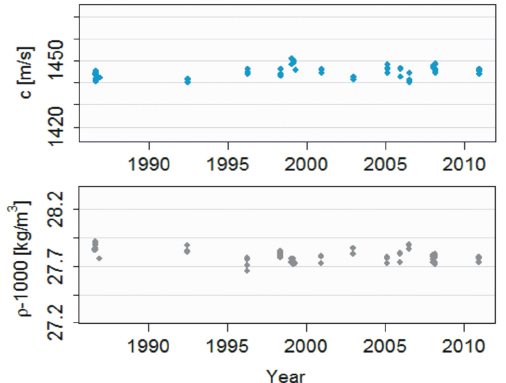
Figure 5. Vertical mean sound velocity (upper panel) and den- sity (lower panel), calculated from CTD (conductivity, temperature, depth) measurements for the upper 150m on the position of AWI- 231. The y-axes span the range ± 2% of the mean value of the re- spective